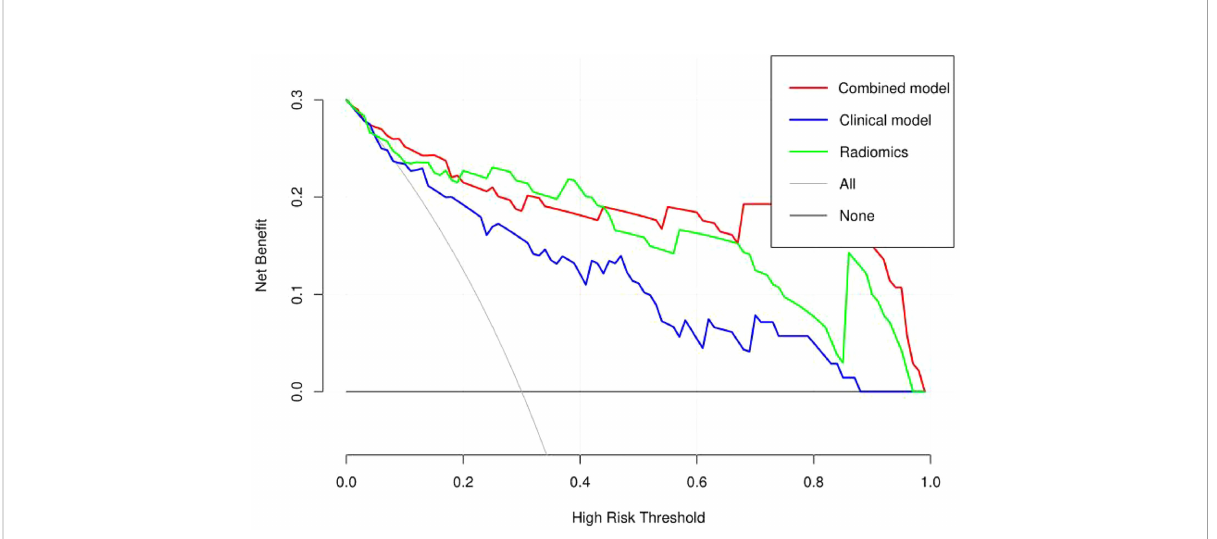
FIGURE 9 Decision curve analysis (DCA) of the combined radiomics nomogram, clinical, and radiomics models in the combined training and validation